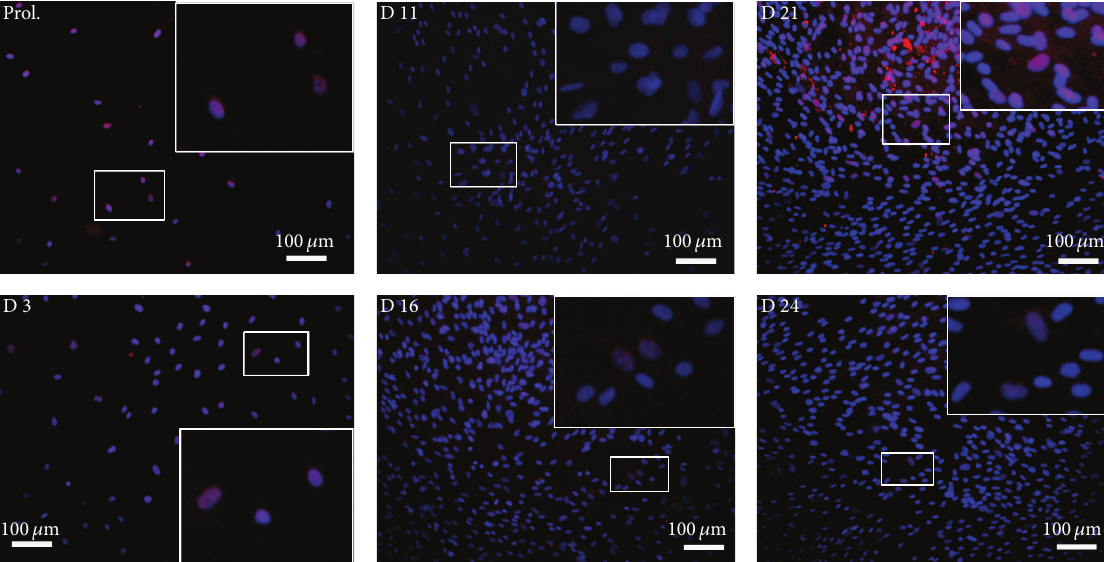
Figure 3: ATF5 during osteogenic differentiation. Immunocytochemical analysis of ATF5 at specific time points (proliferation, days 3, 11, 16, 21, and